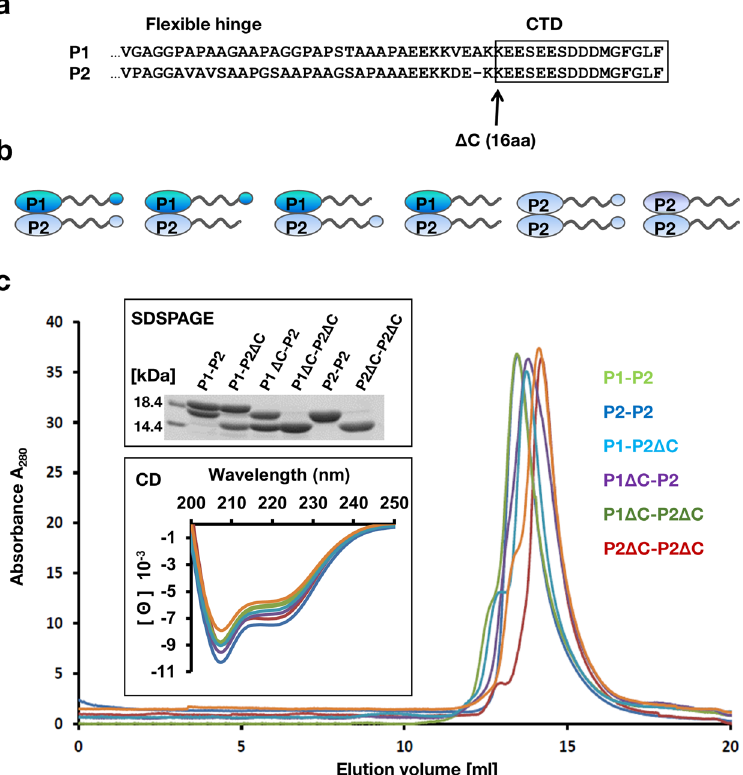
Figure 1. Characterization of human ribosomal stalk P1-P2 complexes. ( a ) Alignment of C-terminal amino acid sequences of human ribosomal P1, P2 protein. The arrow indicates the deletion site for the last 16 amino- acids from the C-termini ( Δ C). ( b ) Models of human ribosomal P1-P2 and P2-P2 complexes deleted in the conserved C-terminal sequences (16aa). (c) Size exclusion chromatography (SEC) of recombinant human P1-P2 protein complexes. Purified complexes (10 μ g of protein) were analyzed by SDSPAGE (upper panel) and circular dichroism (CD) (lower panel). The full-length image of the cropped SDSPAGE gel is shown in Fig. S6.